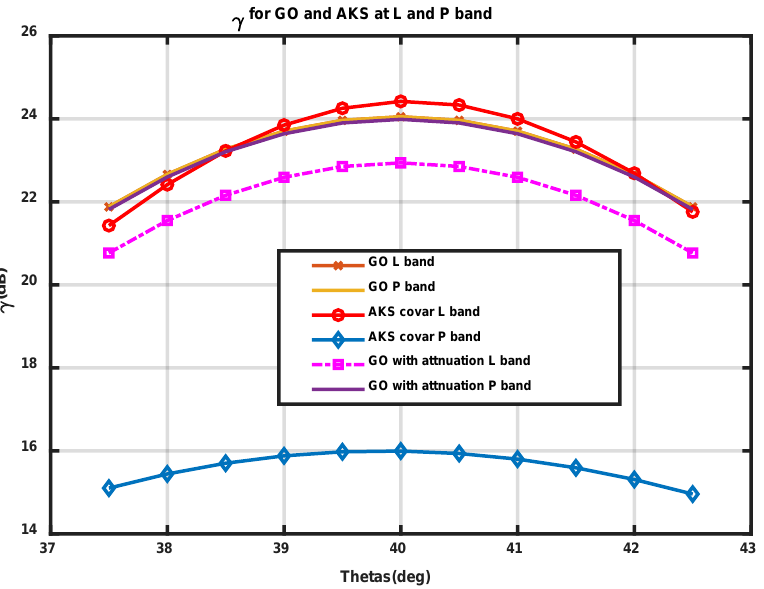
Figure 11. Bistatic scattering coefficient for covariance of fields in the L and P bands with GO, AKS, and IGOM. Results show that AKS has a frequency dependence while GO and IGOM do not. The mean field bistatic coefficient and covariance are shown in Figure 12 for the P-band and L-band. The observation area was centered at ( 0, 0, 0 ) , which is the specular point. The incident angle and scattering angle with respect to the specular point was fixed at θ i = 40 ◦ . The transmitter and receiver positions are given by Equations (79) and (80). Equations (111) and (113) were used to calculate the bistatic scattering coefficients for mean field intensity and Covariance of fields. The rms height and correlation length for f 2 ( x , y ) were 5.78 cm and 3.75 m respectively for the entire 5 km by 5 km area. The land topography data were obtained from SRTM [45] centered at at 37.2116 ◦ N, 105.9756 ◦ W. The land surface was interpolated into 60 m × 60 m grids, and the slopes for coarse topography was obtained by taking the different between adjacent data